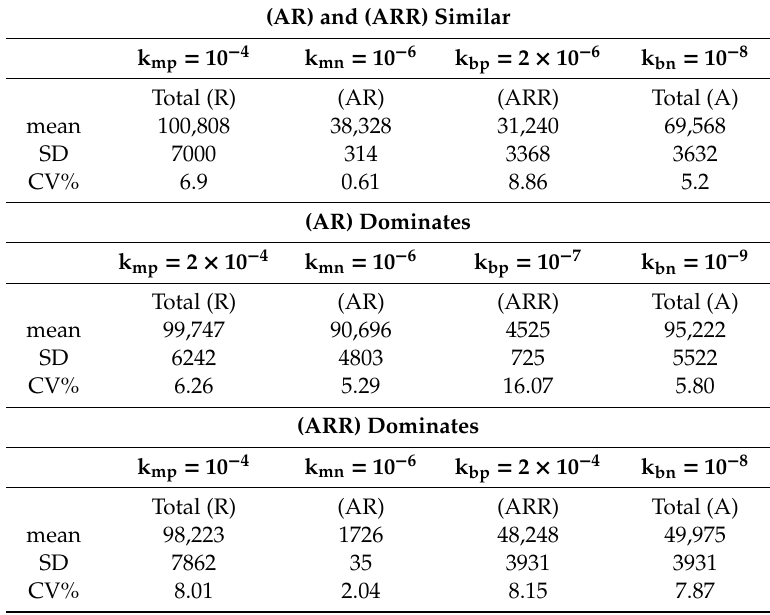
Table 5. Summary of model results for various reaction conditions and varying values of initial ( R